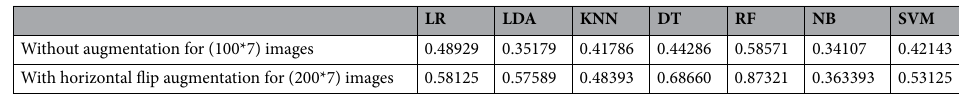
Table 4. Accuracy of the machine learning